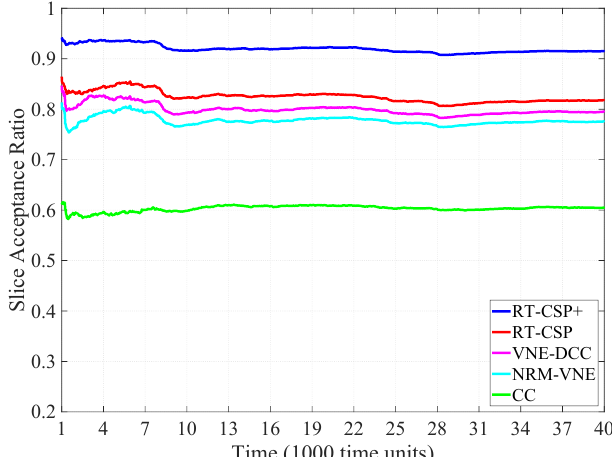
Figure 2. Slice acceptance ratio.